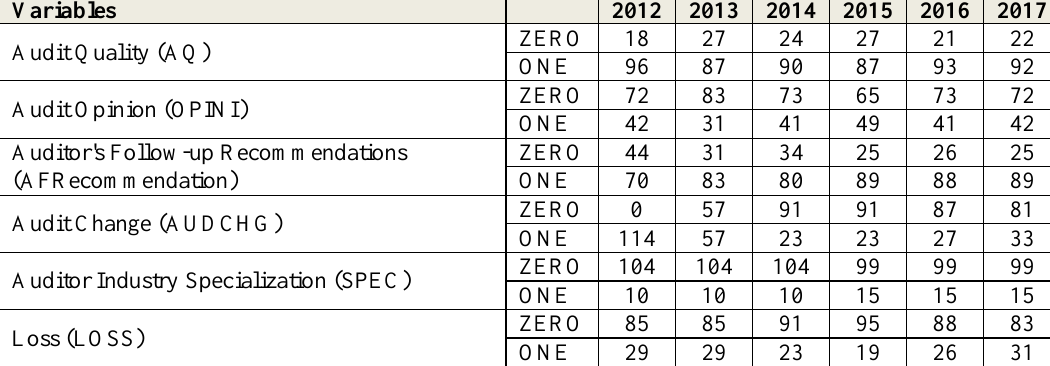
Table 2. Descriptive Statistics of Binary